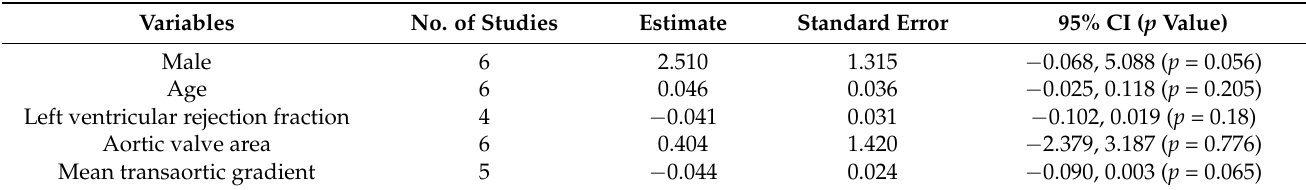
Table 4. Meta-regression of correlation between 3D-TEE and MDCT annular area